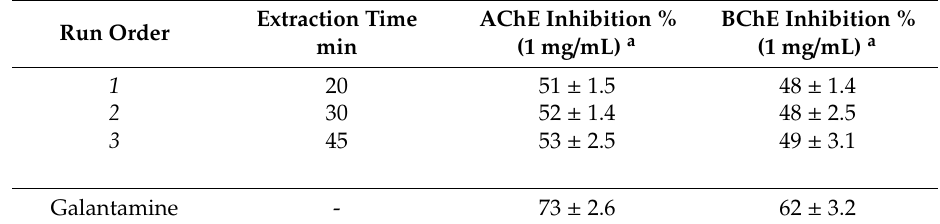
Table 6. Acetylcholinesterase and butyrylcholinesterase inhibitory activity levels of the 80% ethanolic H. erinaceus